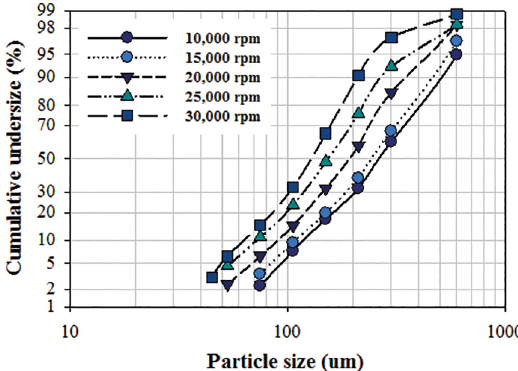
Figure 4. Effect of rotation speed on cumulative mass distribution by particle size. Disk diameter 40 mm, 50 kg/hr melt feed rate, and 550 o C melt